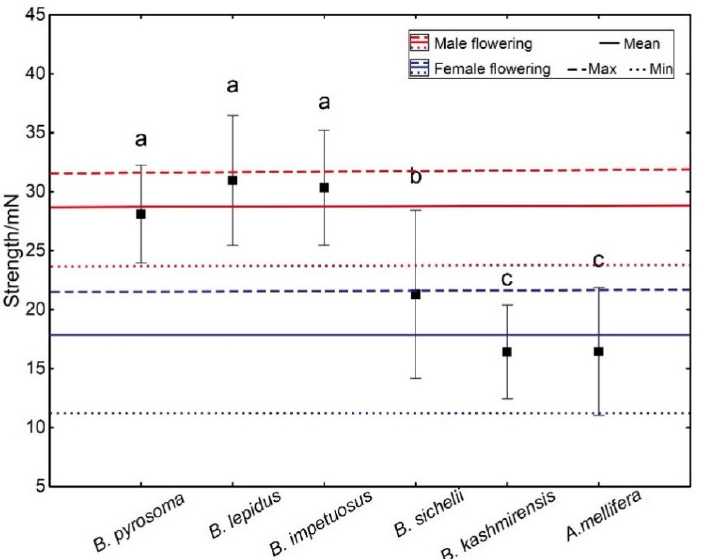
Figure 8. Operative strength of D. caeruleum and local visitors. B. impetuosus , B. lepidus , and B. pyrosoma are visitors of D. caeruleum . Means ± SD are shown. The bars with different letters (a, b, and c) indicate significant differences between the means at p <